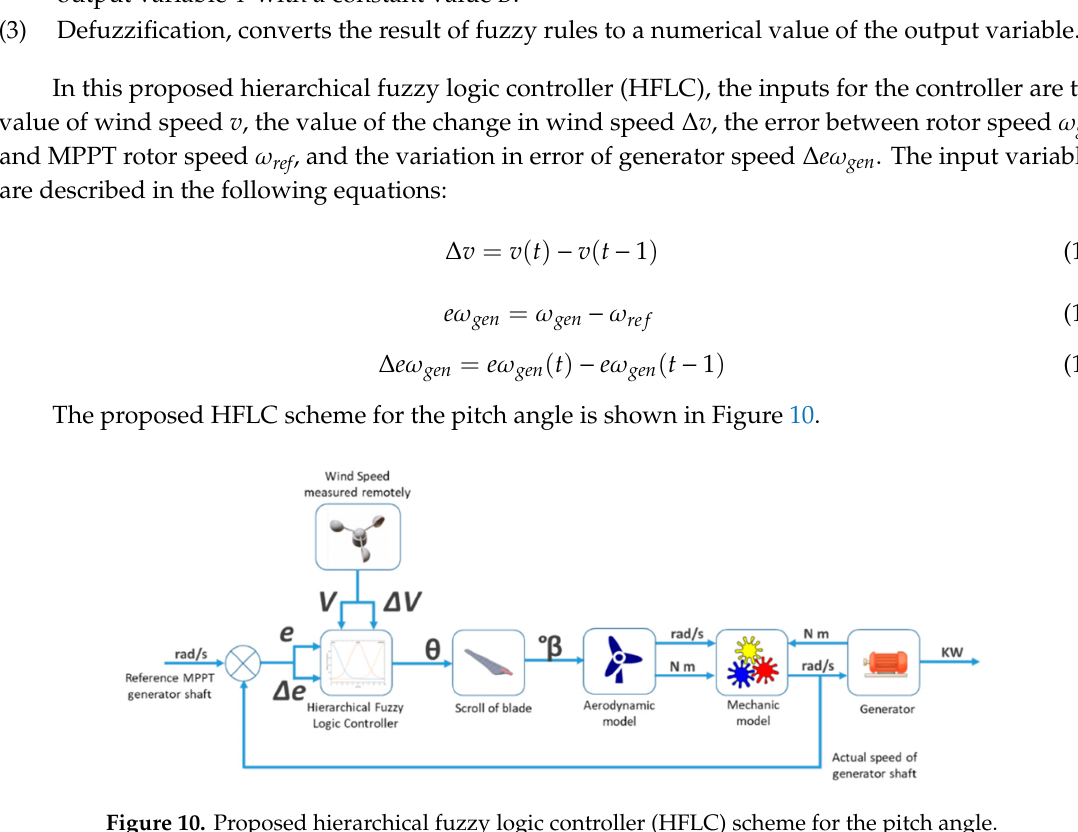
Figure 10. Proposed hierarchical fuzzy logic controller (HFLC) scheme for the pitch angle.